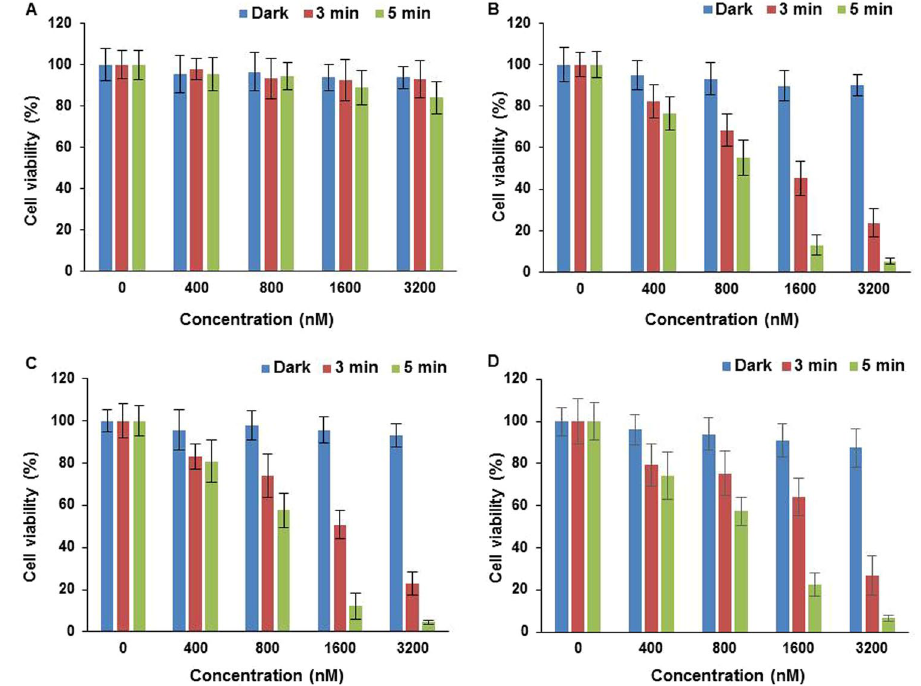
Figure 5. PDT effect of chlorin e 6 without Tat-peptide conjugation ( A ), 7 ( B ), 8 ( C ) and 9 ( D ) in MC28 cells. Cells were incubated with the compounds at various concentrations and were illuminated for either 3 or 5 minutes. MTT assay was carried out 48 h after light exposure. Data are presented as mean value ± standard deviation (SD) of three independent experiments.